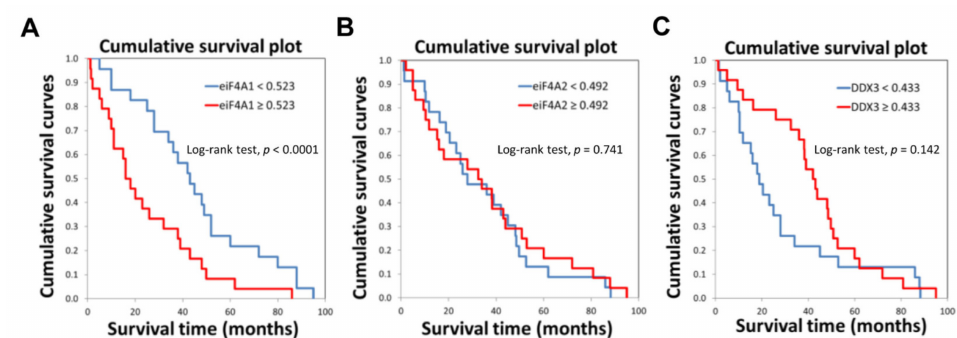
Figure 3. Levels of eIF4A1 protein negatively correlate with the survival of patients with hepatocellu- lar carcinoma (HCC) (n = 47). Kaplan-Meyer curves in HCC patients for eIF4A1 ( A ), eIF4A2 ( B ), and DDX3 ( C )